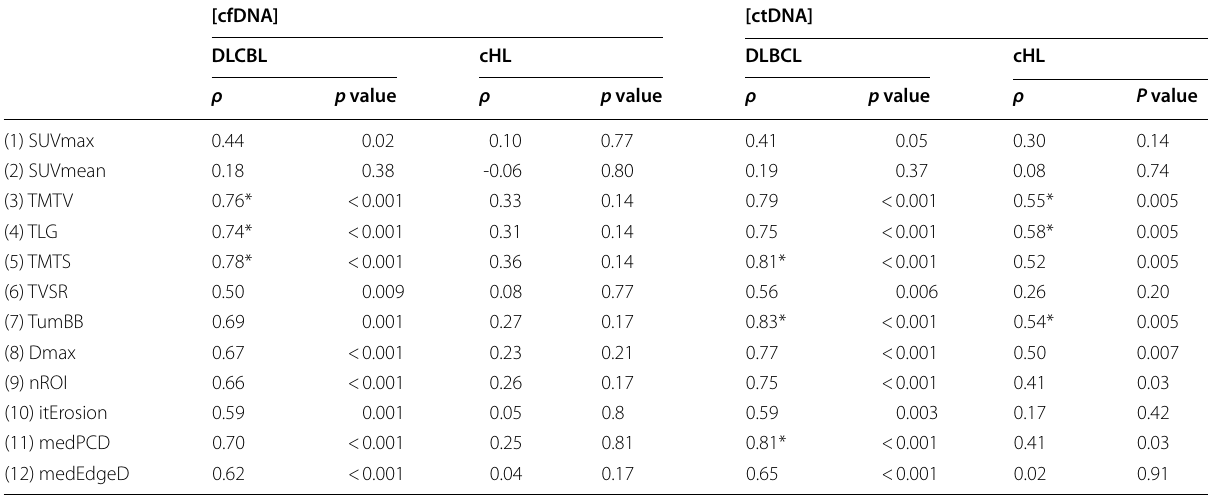
p values controlled by Benjamini–Hochberg